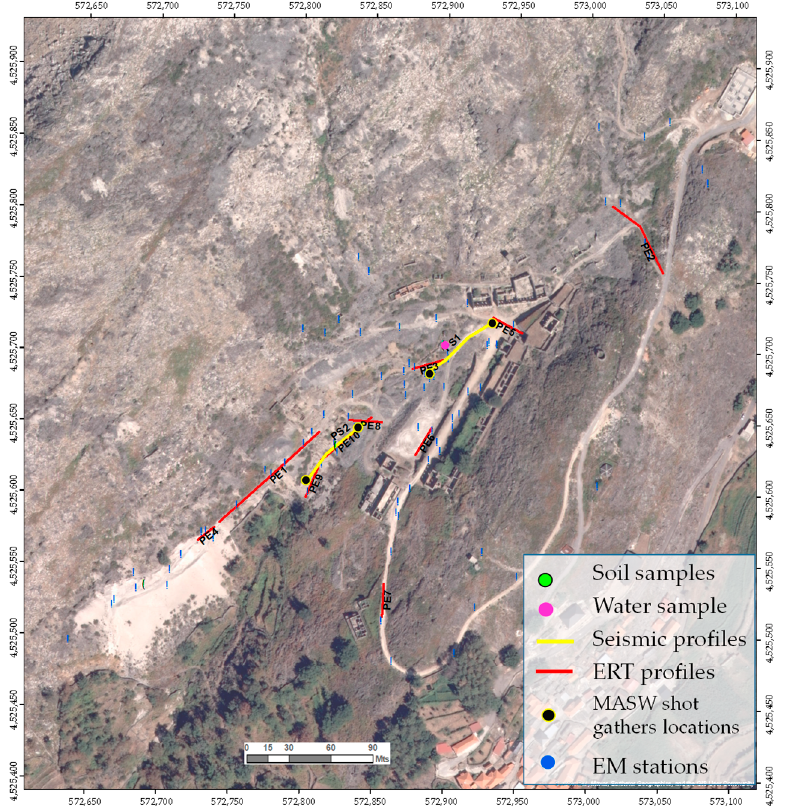
Figure 3. Location of soil and water samples, electrical resistivity transverse profiles (ERT), electro- magnetic stations (EM), and profiles used for seismic refraction and MASW analysis.